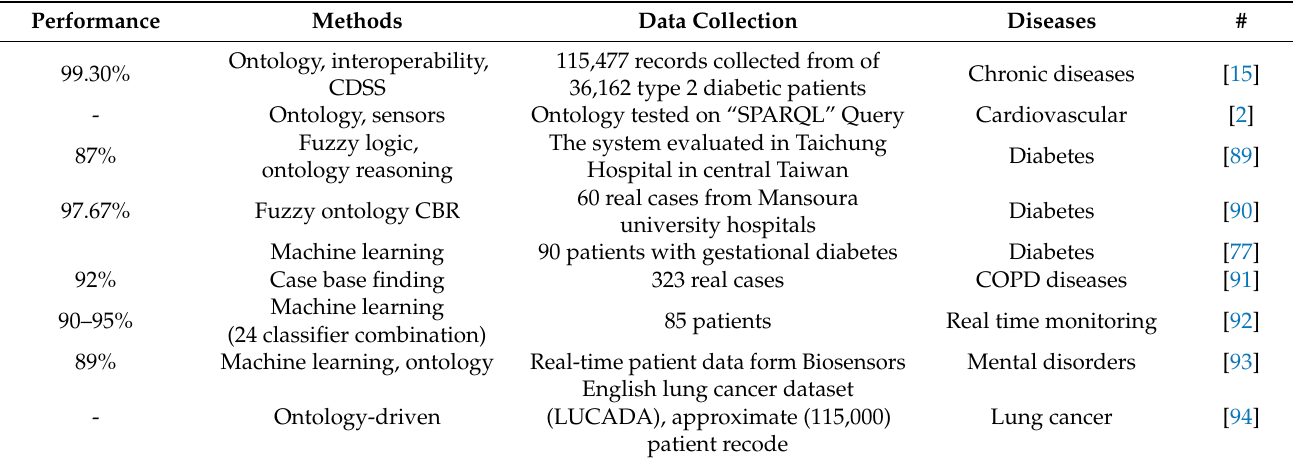
Table 5. Description of CDSS